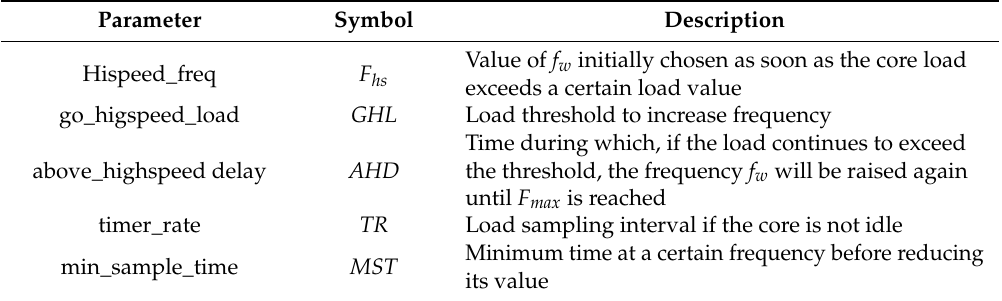
Table 1. Interactive parameters.